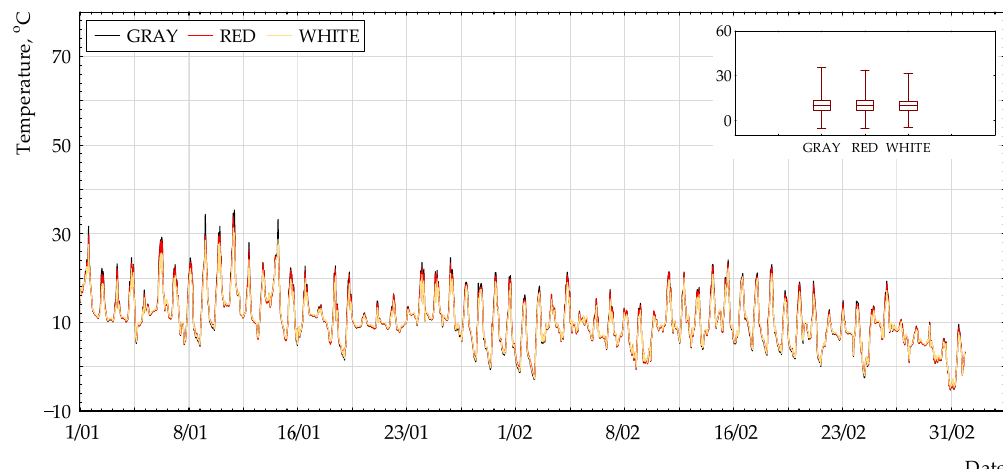
Figure 2. Surface temperature (N_45°) for the period of 1 July to 31 August 2017.